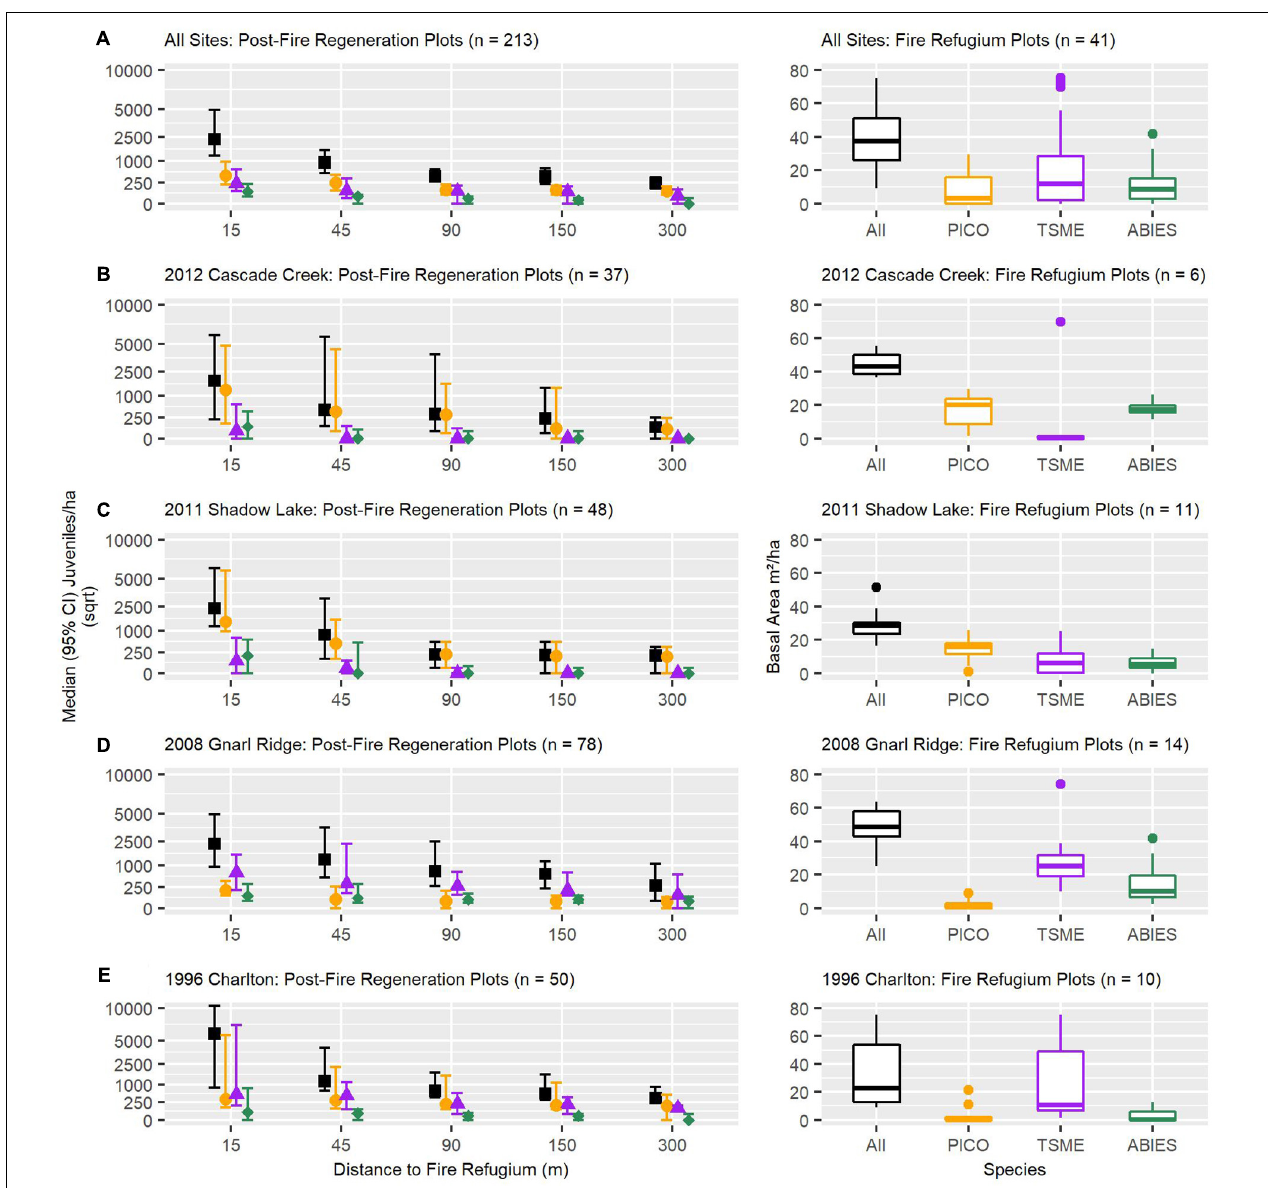
FIGURE 2 | Observed post-fire median (95% confidence intervals) conifer establishment (density) as a function of increasing distance to refugium patch edge (left panels) and refugium patch basal area (right panels), represented across all and individual study fire perimeters (A–E) , by dominant and all conifer species combined. TSME, mountain hemlock ( Tsuga mertensiana ); PICO, lodgepole pine ( Pinus contorta ); ABIES, pacific-silver fir and subalpine fir ( Abies amabilis/lasiocarpa